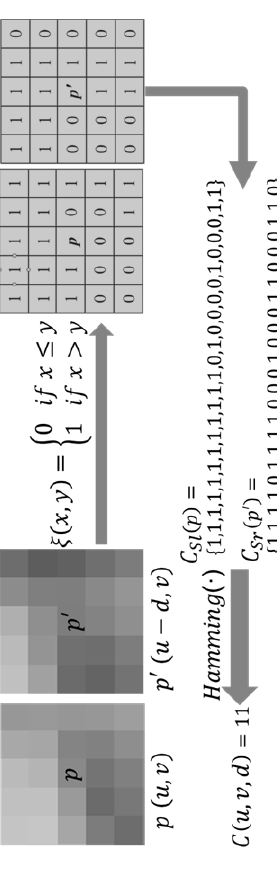
Figure 1. The matching cost computation based on